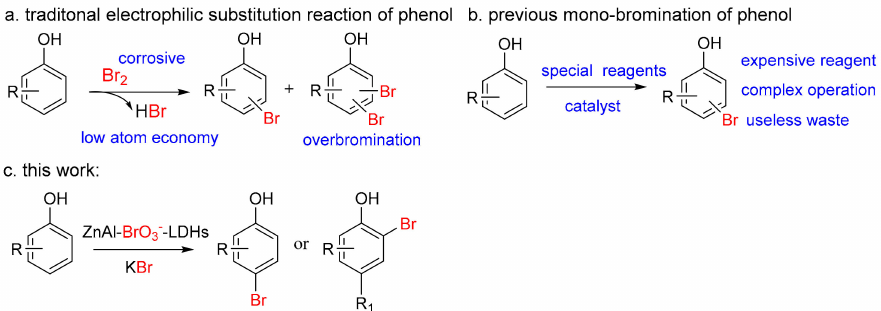
Figure 1. Three bromination of phenols; ( a ) traditional electrophilic substitution reaction of phenol; ( b ) previous mono-bromination of phenol; ( c ) this